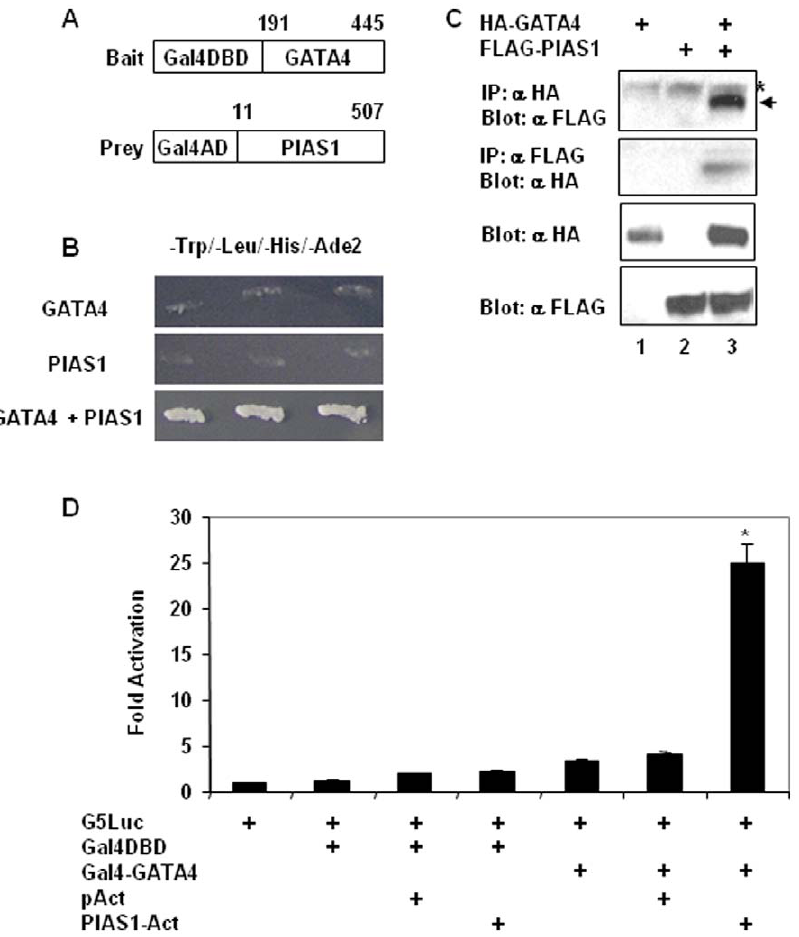
Figure 1. GATA4 and PIAS1 interact in yeast and mammalian cells. Panel A. The bait vector and the longest PIAS1 prey clone captured in the yeast two-hybrid screen are depicted diagrammatically. The numbers correspond to amino acids of the full length GATA4 and PIAS1 proteins. Abbreviations: Gal4DBD: Gal4 DNA binding domain; Gal4AD: Gal4 activation domain. Panel B. Yeast colonies transformed with rescued Gal4DBD- GATA4 (top panel) or Gal4AD-PIAS1 (middle panel) vectors or cotransformed with both (bottom panel) were streaked on quadruple dropout media. Panel C. HCT116 cells were transfected with HA epitope tagged GATA4 (lane 1) or FLAG epitope tagged PIAS1 (lane 2) or both (lane 3). Equal amounts of total protein lysates were immunoprecipitated with HA antibody and probed with FLAG antibody (top panel) or immunoprecipitated with FLAG antibody and probed with HA antibody (second panel). Third and fourth panels correspond respectively to western blots of input lysates with HA antibody and FLAG antibody. In the top panel, asterisk and arrow indicates nonspecific bands and the specific band, respectively. Panel